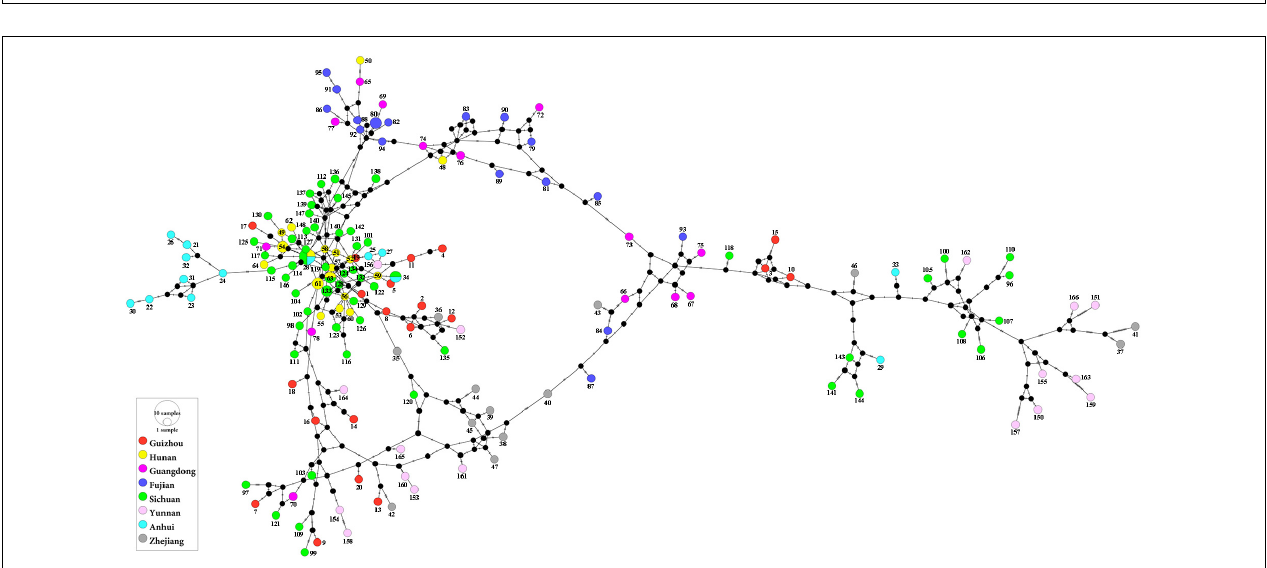
FIGURE 5 | The median-joining network of the haplotypes of Aphis aurantii . Haplotypes from each province were, respectively, indicated by colored circles .